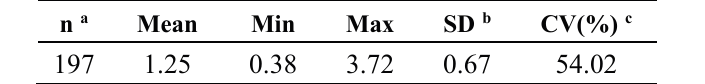
Table 5. Descriptive statistics for the mean accuracies (m) for subplot center coordinates.